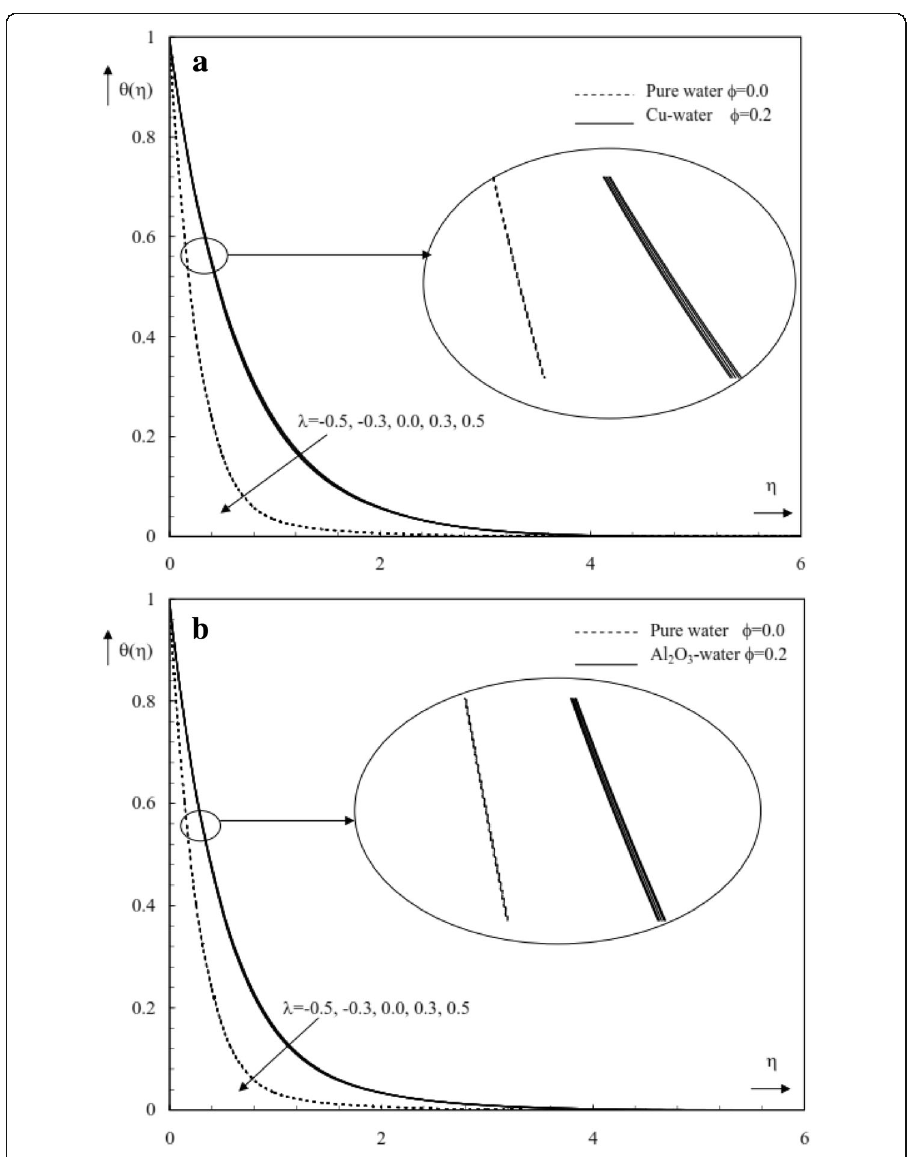
Fig. 14 Effects of ϕ and λ on temperature distribution θ ( η ) for S = M = f w = 0.1 and A = B = 0.5 for a Cu- water and b Al 2 O 3